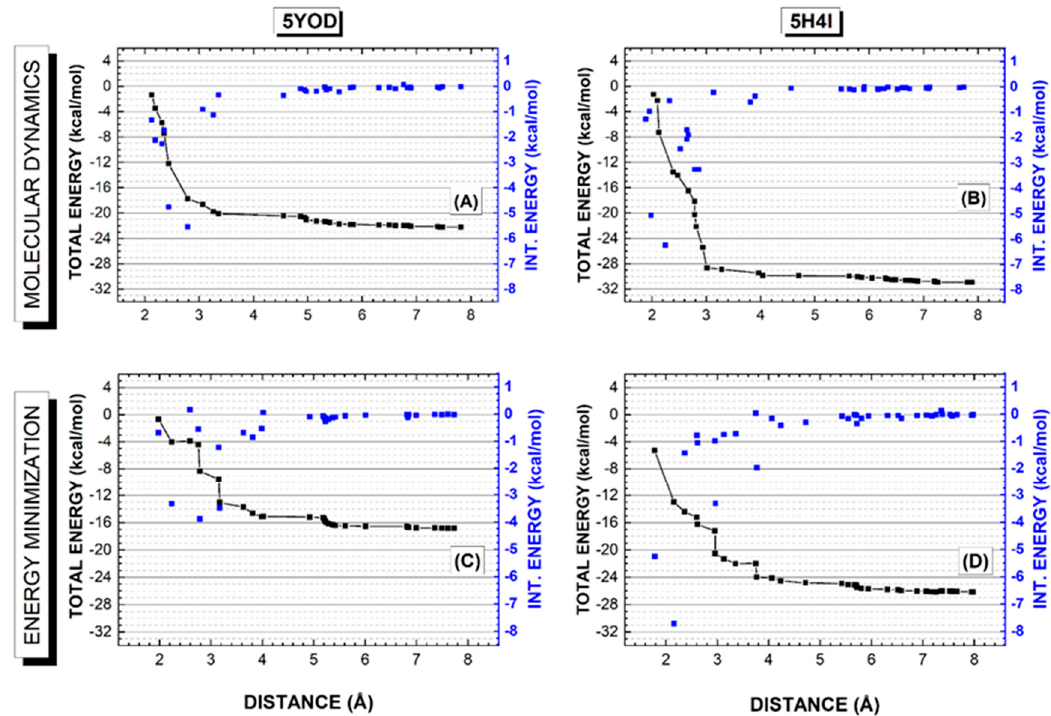
Figure 6. Quantum biochemistry calculations for the PDB structures 5YOD and 5H4I modified after a 5-ns molecular dynamics simulation (top) and after classical energy minimization (bottom). ( A , C ): 5YOD interaction energy (black line + scatter) and the interaction energies of the individual residues included as the distance from the ligand is increased (blue scatter and blue scale right axis). ( B , D ): 5H4I interaction energy (black line + scatter) and the interaction energies of the individual residues included as the distance from the ligand is increased (blue scatter and blue scale right axis).